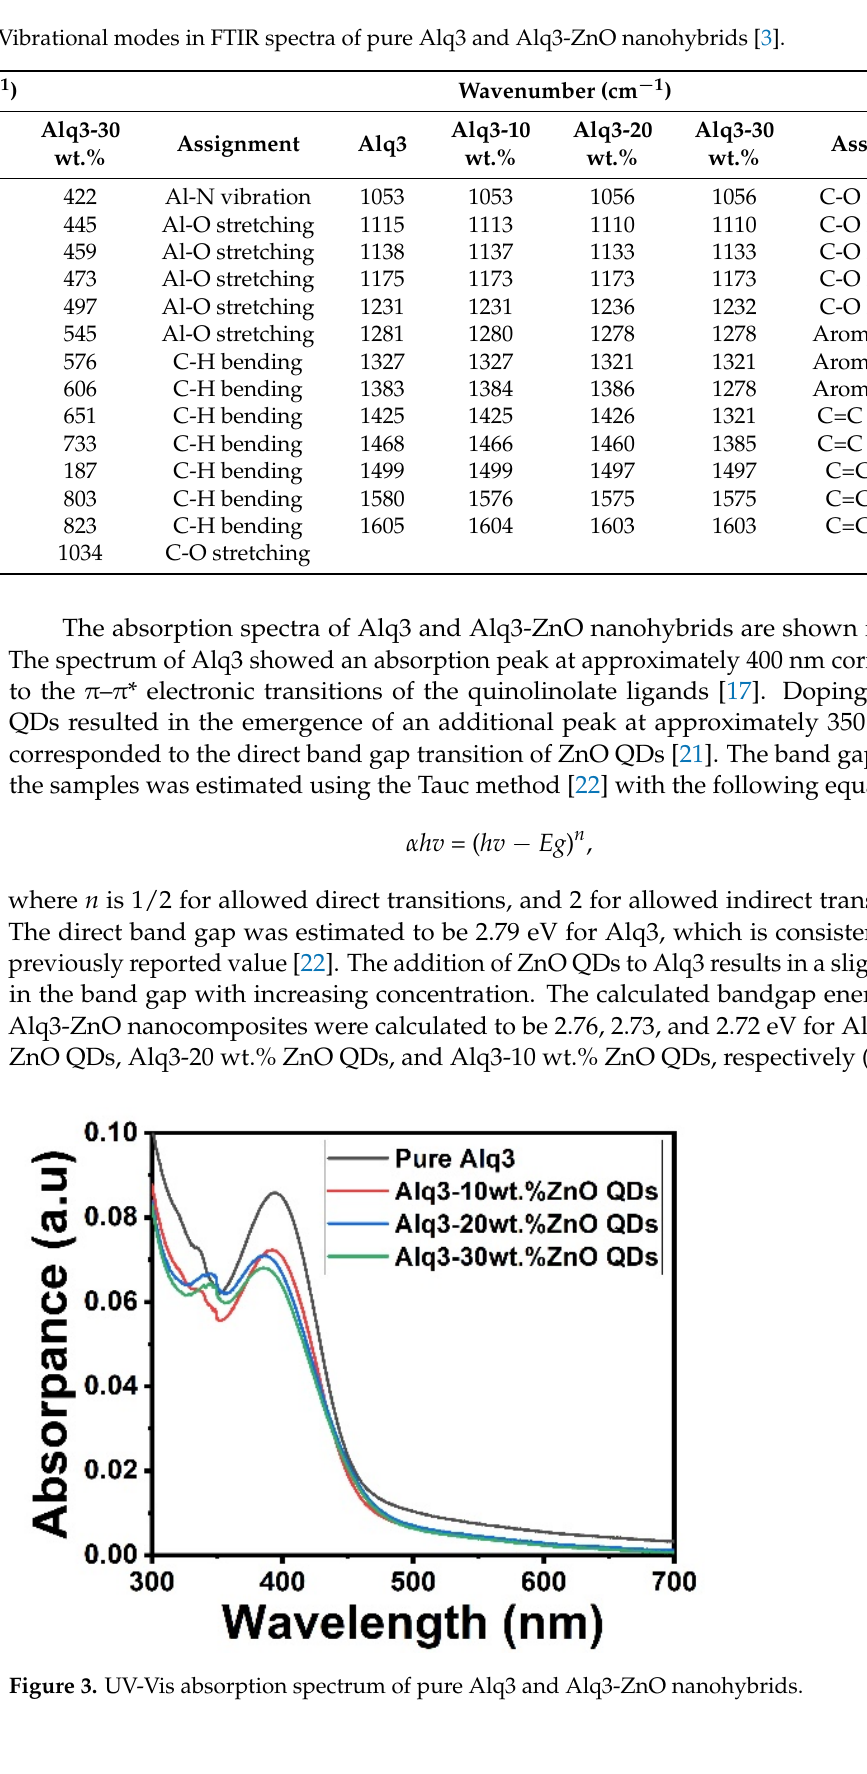
Figure 4. ( α h ν ) 2 versus h ν curves for ( a ) pure Alq3, ( b ) Alq3-10 wt.% ZnO QDs ( c ) Alq3-20 wt.% ZnO QDs ( d ) Alq3-30 wt.% ZnO QDs. The PL spectra of Alq3 and Alq3-ZnO nanohybrids after excitation with a He-Cd laser (325 nm) are shown in Figure 5. Pure Alq3 exhibits green emission centered around 525 nm. The presence of ZnO QDs results in introducing a new energy sate within the energy band gap of the Alq3 and hence results in a double-hump emission, the first due to the Alq3 molecules and the second due to the presence of ZnO QDs. Additionally, the